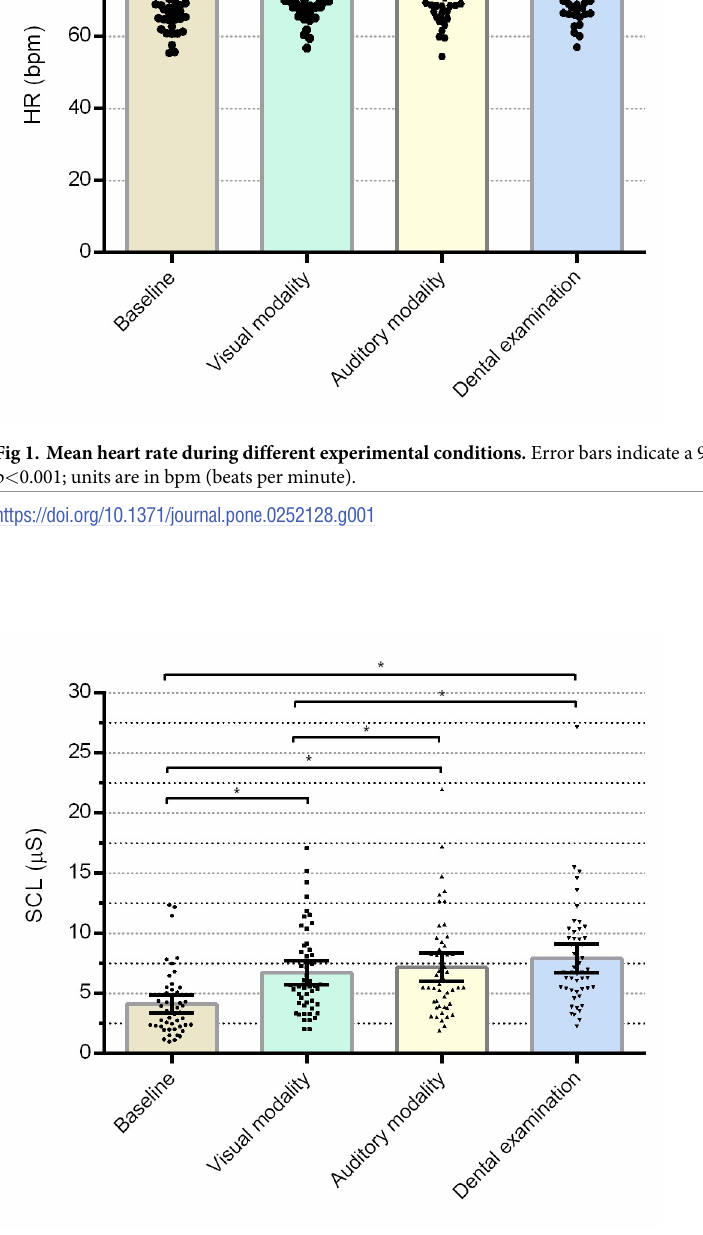
Fig 2. Mean skin conductance level during different experimental conditions. Error bars indicate a 95% confidence interval; � p < 0.001; units are in μ S (micro Siemens).